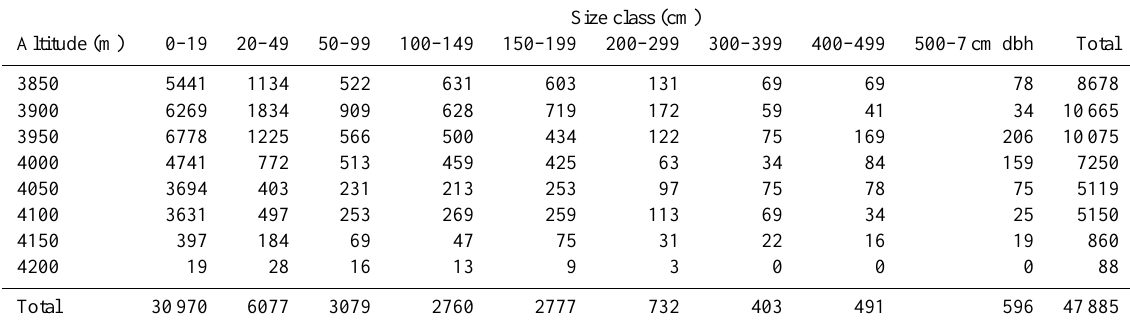
Figure 9. Spearman rank correlations between seedling/sapling abundance and soil temperature and soil moisture in the treeline ecotone in Rolwaling Valley. Table 2. Cumulative numbers of seedlings/saplings (Nha − 1 ) of Betula utilis , Abies spectabilis , Rhododendron campanulatum , and Sorbus microphylla in the treeline ecotone in Langtang Valley according to altitude and size classes (dbh: diameter at breast